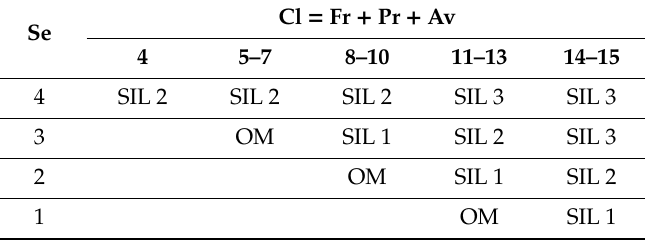
Table 9. Risk graph for IEC 62061 using two severity of harm Se and probability of harm